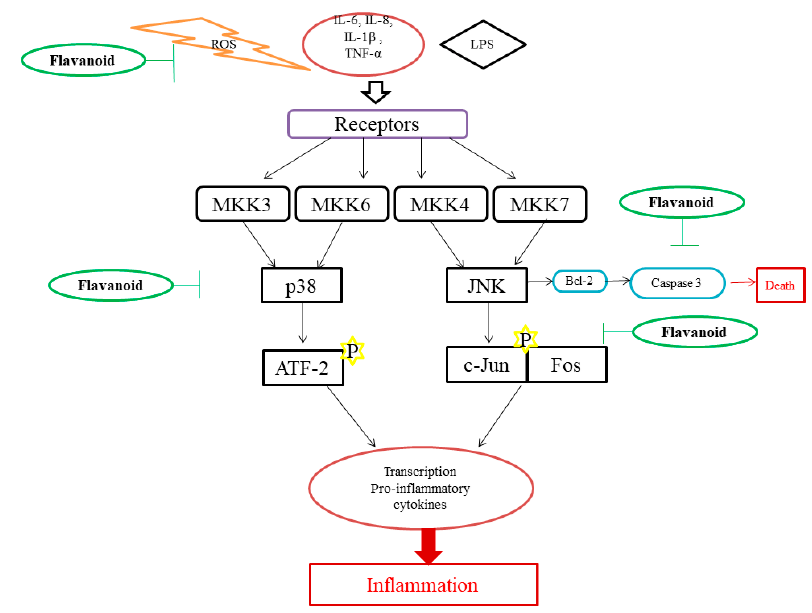
Figure 4. Anti-inflammatory action of